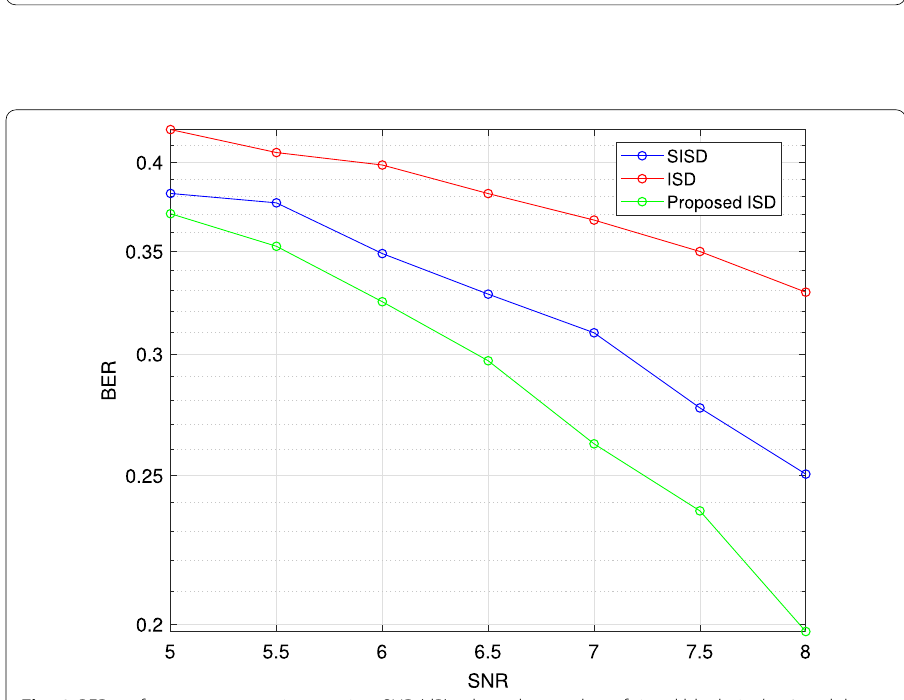
Fig. 6 BER performance comparison against SNR (dB), where the number of signal blocks is d number of continuous time slots is J